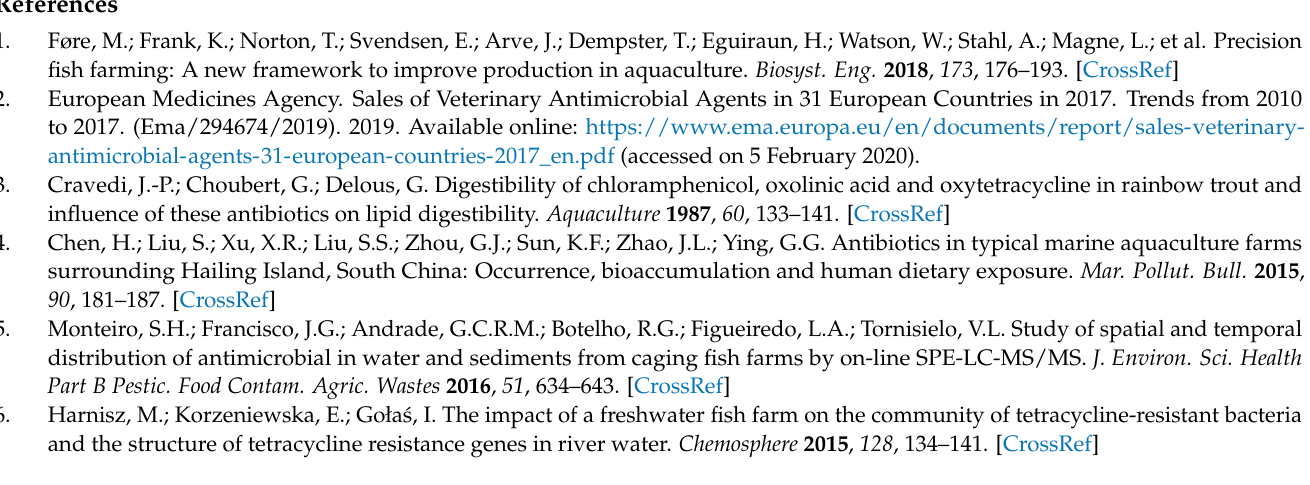
STX. Table S3: qPCR primers and conditions of 16S rRNA gene and tetracycline resistance genes (tet). Table S4: The qPCR reaction efficiency (E) and correlation coefficients (R2) for 16S rRNA gene and tetA at each sampling time (5 days of exposure: 5dE; 2 months of exposure: 2mE and 5 days of post-exposure: